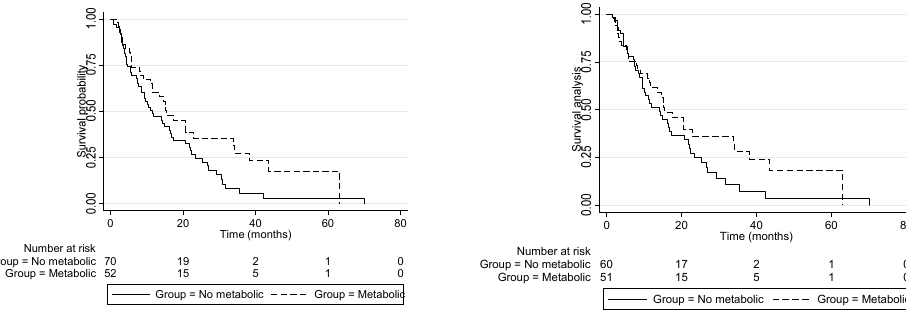
Figure 1. Kaplan–Meier curves showing: ( Left ) overall survival according to subgroup with metabolic disorders vs. no metabolic disorders. The median overall survival of the “metabolic disorder” group was 15.5 months (95% CI 10.9–33.9), and the median OS of the “non-metabolic-disorder” group was 11.5 months (95% CI 8.4–16.5), adjusted HR: 1.09 (0.62–1.94), p = 0.745. ( Right ) overall survival according to subgroup with metabolic disorders vs. no metabolic disorders, excluding patients managed with best supportive care. The median overall survival of the “metabolic disorder” group was 15.5 months (95% CI 11.4–33.9), and the median OS of the “non-metabolic-disorder” group was 14.0 months (95% CI 9.4–17.3), adjusted HR: 1.32 (0.74–2.35), p = 0.351. There was no correlation between the group (metabolic vs. non-metabolic) and the tumor site ( χ 2 = 1.46; p = 0.691). Interestingly, the median overall survival for patients with intrahepatic cholangiocarcinoma and in the metabolic group ( n = 30) was 7.7 months (95% CI 3.1–11.9), and for patients with intrahepatic cholangiocarcinoma and in the